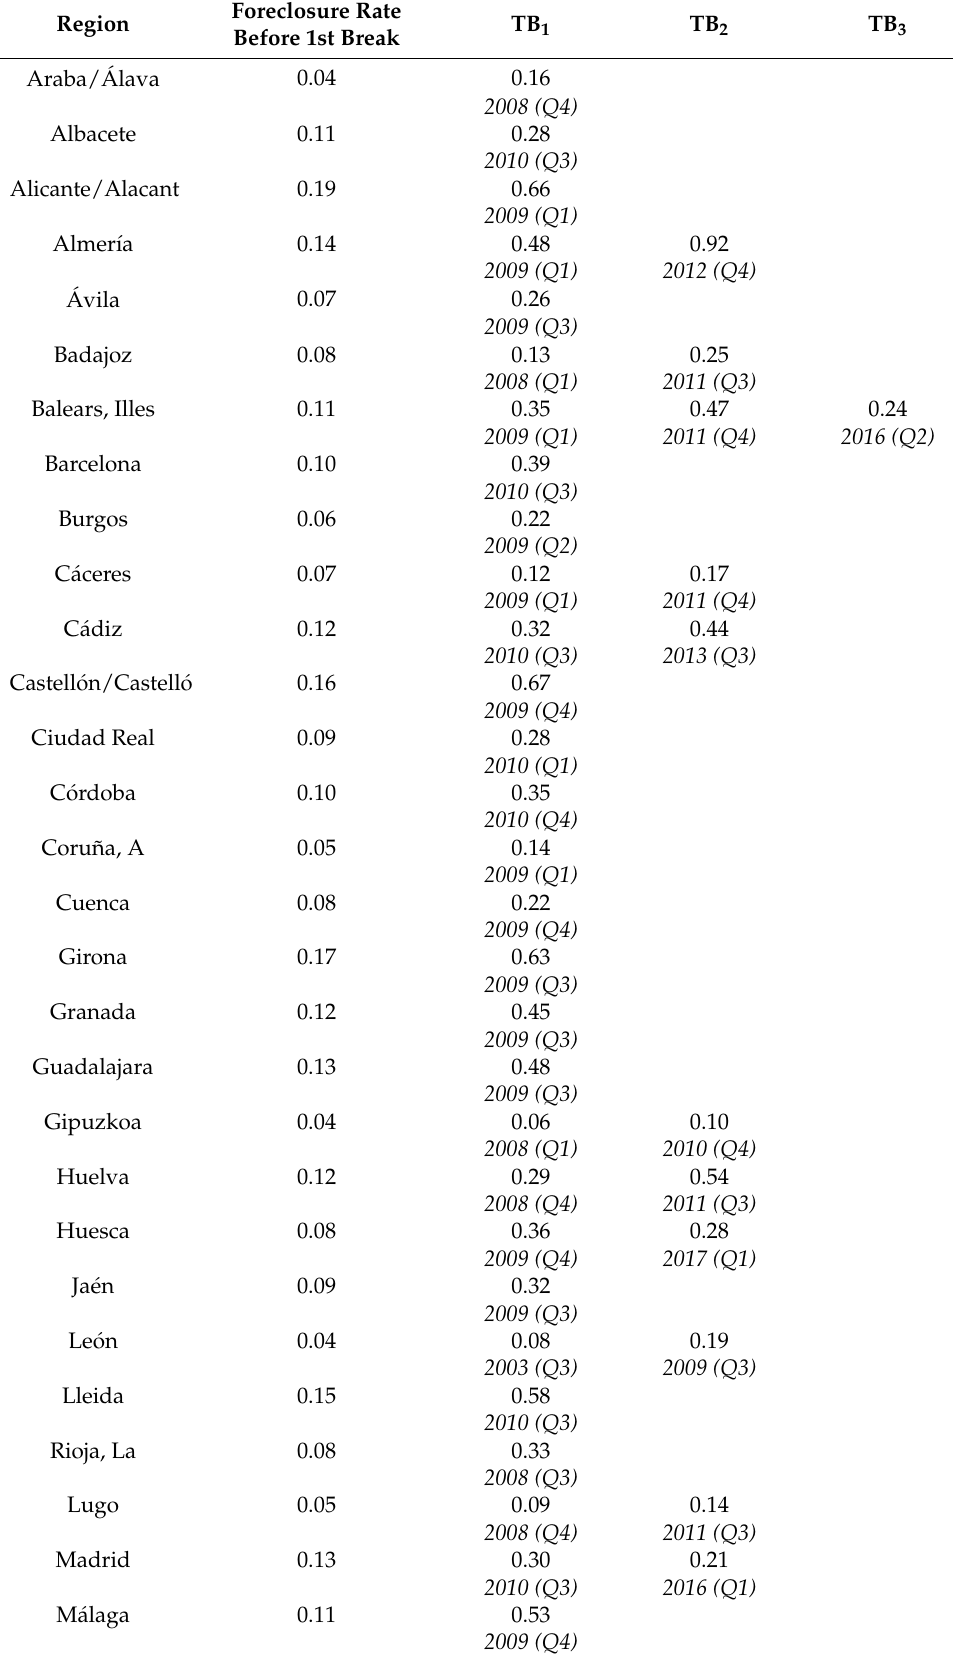
Table 5. Unit root tests on foreclosure rates, multiple structural